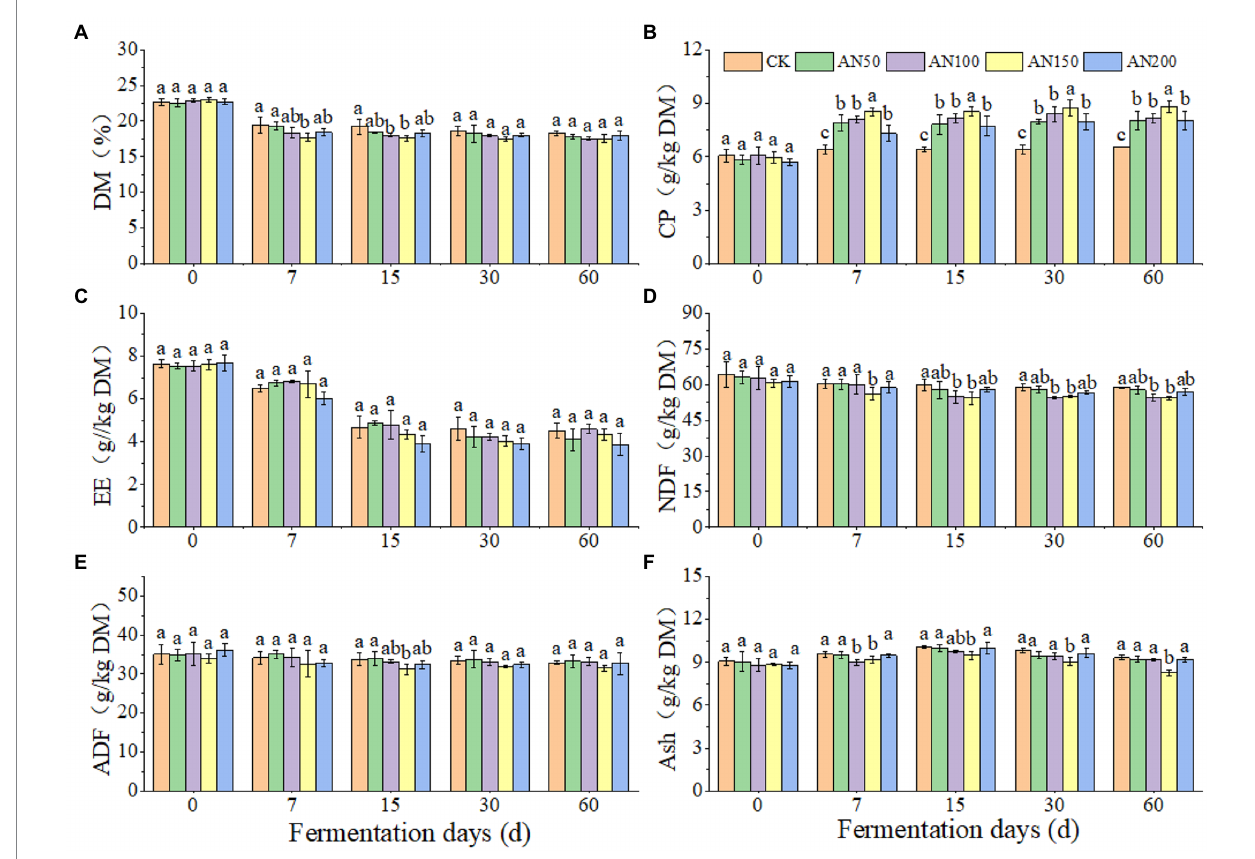
FIGURE 4 Nutrients of ratooning sorghum ensiled with different concentrations of A. niger . (A) dry matter (DM); (B) , crude protein (CP); (C) , ether extract (EE); (D) , neutral detergent fiber (NDF); (E) , acid detergent fiber (ADF); (F) , ash. CK: 200 mL of sterile water per 3 kg of silage; AN50: 50 mL A. niger. + 150 mL sterile water per 3 kg of silage; AN100:100 mL A. niger. + 100 mL sterile water per 3 kg of silage; AN150: 150 mL A. niger. + 50 mL sterile water per 3 kg of silage; AN200: 200 mL A. niger. per 3 kg of silage. Different lowercase letter above the data bar represented significance between concentrations of A. niger. within same fermentation time at p <